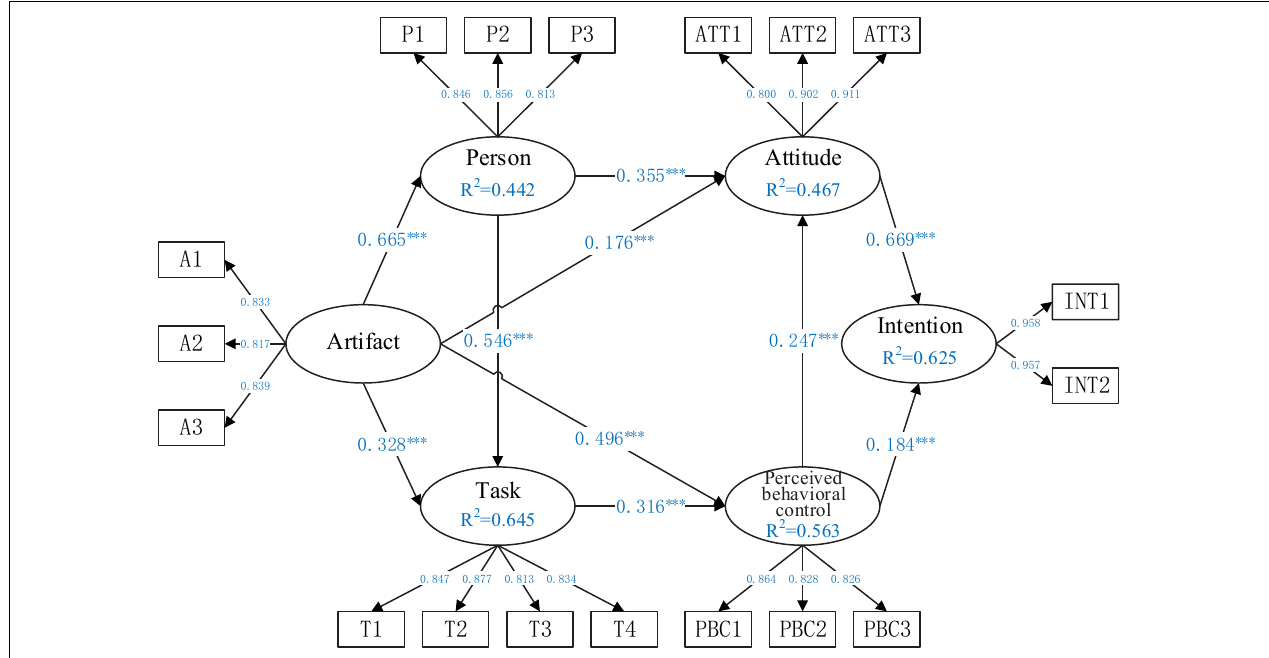
FIGURE 3 | Structural model and paths coefficient. ***refer to the significance level at 0.01. TABLE 5 | The t -value of research hypotheses and path coefficients.